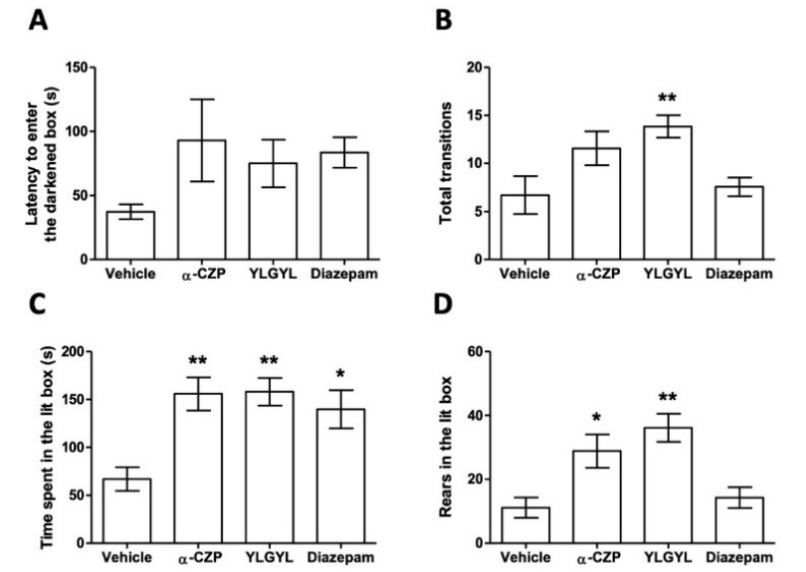
Figure 1. Ethological effects of α -casozepine ( α -CZP), YLGYL, and diazepam on the behavioural response in the light/dark box in Swiss mice. (A) Latency to enter the darkened box; (B) Total transitions; (C) Time spent in the lit box; (D) Rears in the lit box. Mice were IP injected 30 min earlier with the vehicle, α -CZP (1 mg/kg), YLGYL (0.5 mg/kg), or diazepam (1 mg/kg). Results were analysed using a one-way analysis of variance (ANOVA) to detect the effect of the treatment on the studied behavioural scores. Subsequent comparisons were made using Bonferroni post hoc tests. Data are mean ± SEM ( n = 7–8/group). * p < 0.05, ** p < 0.01 compared to the vehicle.